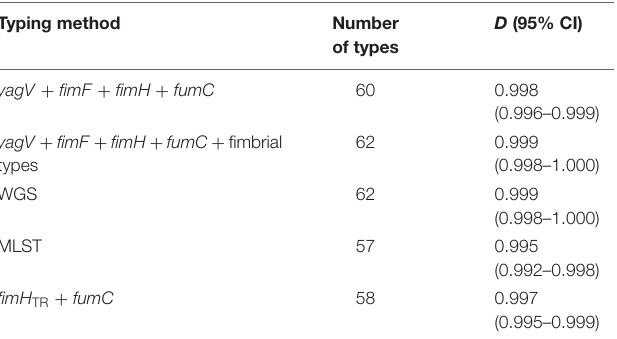
TABLE 2 | Numbers of types and D -values based on different typing methods of 63 UPEC strains with available genome sequences. Typing